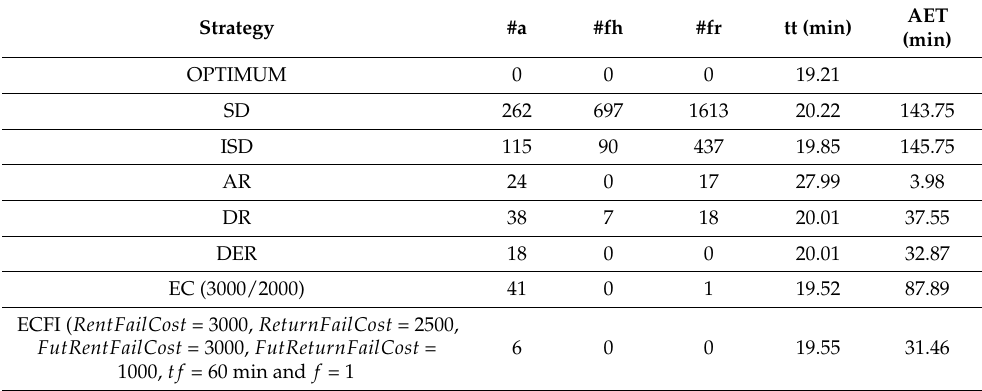
Table 5. Comparison of strategies with real station capacities and number of bikes.